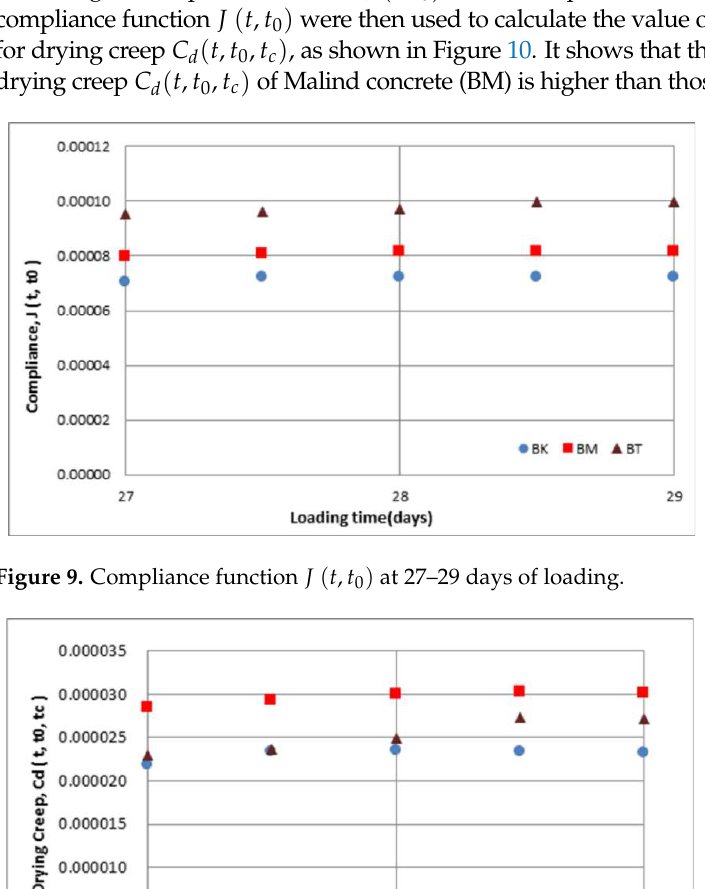
Figure 10. Compliance functions for drying creep C d ( t , t 0 , t c )